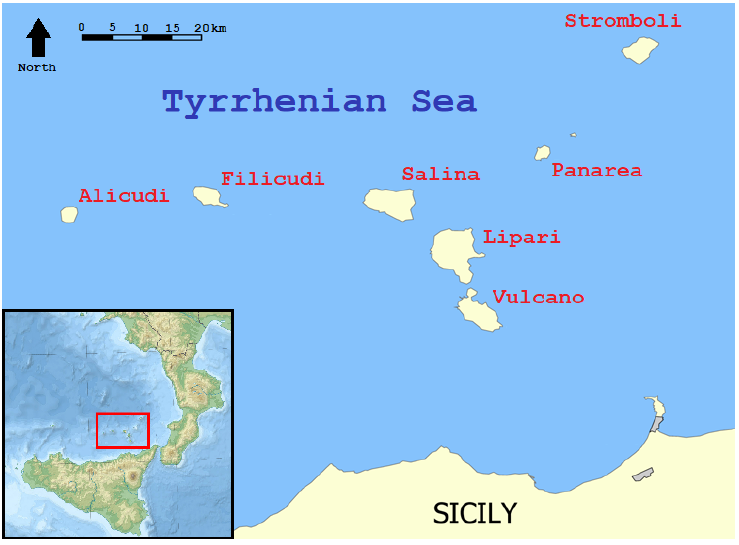
Figure 3. Aeolian Islands in the Tyrrhenian Sea (Italy).